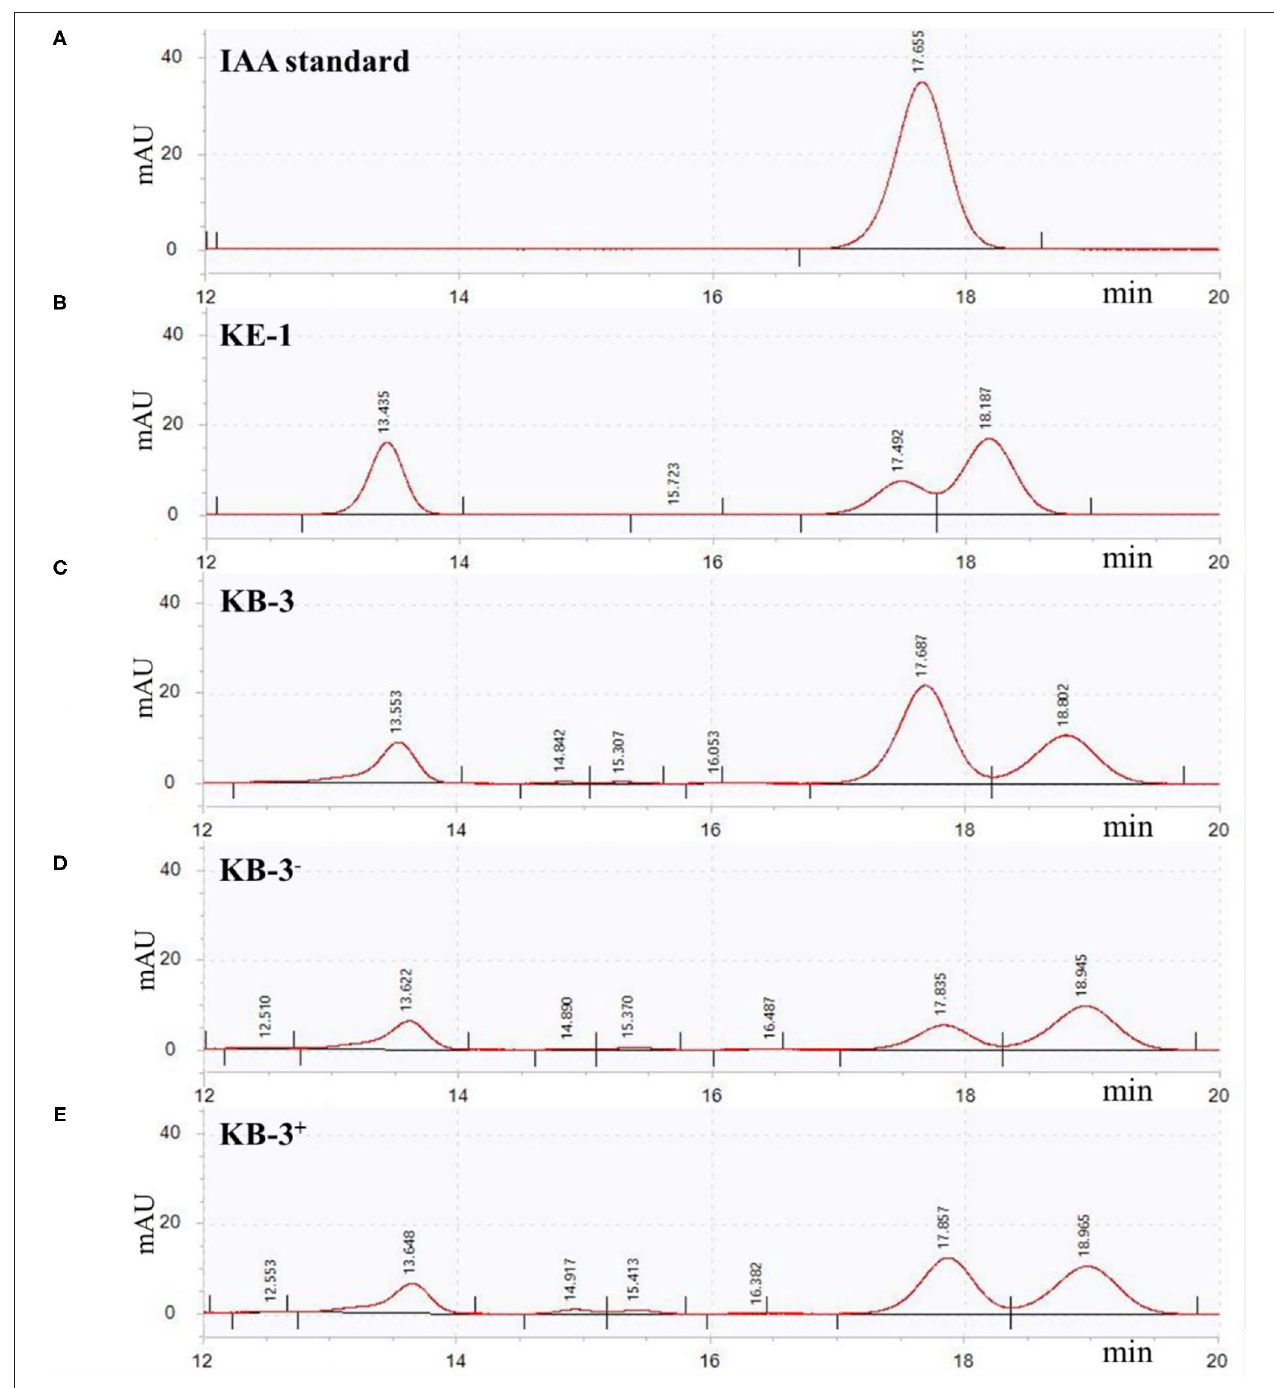
FIGURE 4 | HPLC results for (A) IAA standard, and filtrate extracts from (B) endohyphal bacterium Klebsiella aerogenes KE-1, (C) wild strain KB-3 of Fusarium oxysporum (KB-3), (D) cured strain KB-3 (KB-3 − ) and (E) restored strain KB-3 (KB-3 + ) at 60h of inoculation in the Luria-Bertani (LB) containing 10 mg/ml L-tryptophan. Elution time was 17.65min for the IAA standard, 17.49 for KE-1, 17.68 for wild strain KB-3, 17.83 for cured strain KB-3 (KB-3 − ), and 17.85 for restored strain KB-3 (KB-3 + ). The small difference in retention time reflected partial masking of constituents in the sample matrix, a common phenomenon for HPLC analysis using reversed-phase